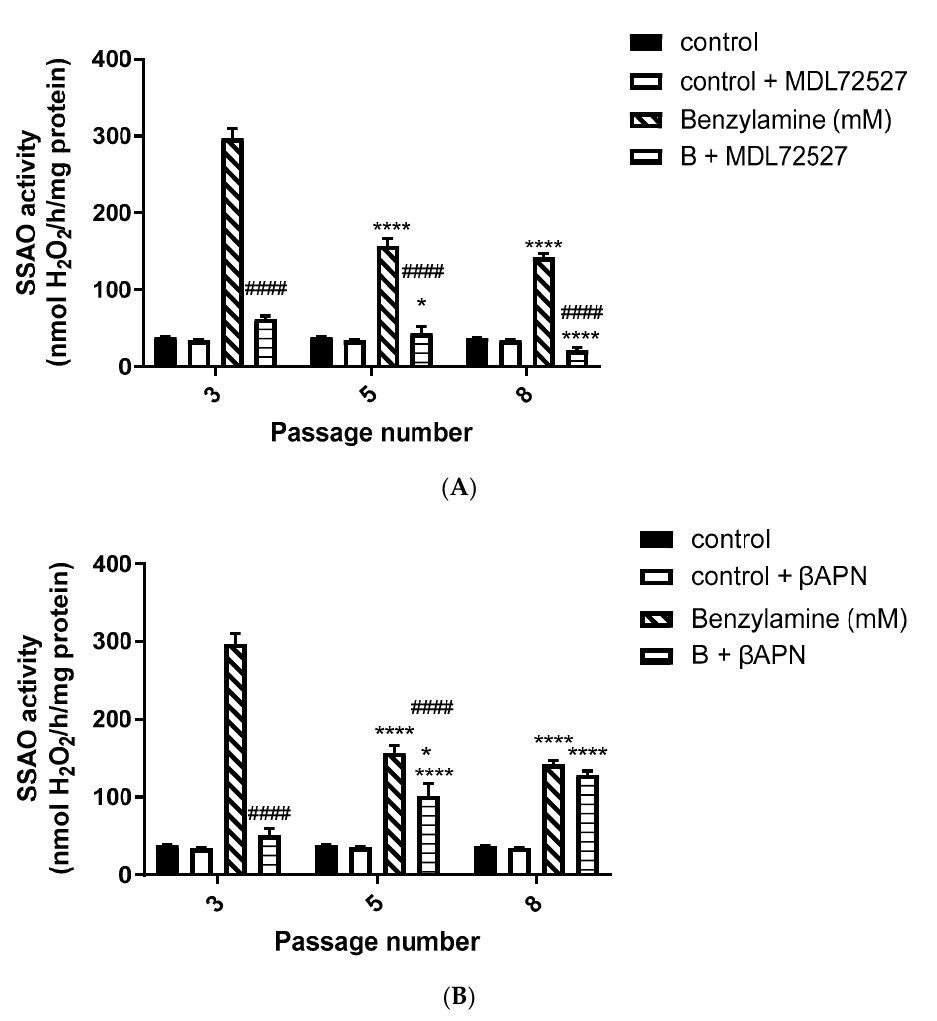
Figure 1. SSAO activity in VSMCs from passages 3, 5, and 8 at the basal level, and after MDL72527 and β APN treatment. ( A ) Cells were treated with a reaction mixture containing 0.5 mM benzyla- mine (hatched bars); 0.5 mM benzylamine + 100 μ M MDL72527 (horizontal line bars); a reaction mixture without benzylamine (control—solid bars) and a reaction mixture without benzylamine + MDL72527 (control + MDL72527, open bars).**** p < 0.0001 for cells passage 5 vs . 3 and 8 vs . 3 after treatment with benzylamine; **** p < 0.0001 for cells passage 8 vs. 3 and * p < 0.05 for cells passage 5 vs. 8 after treatment with benzylamine + MDL72527; #### p < 0.0001 for B + MDL vs . benzylamine at passages 3, 5, and 8. ( B ) Cells were treated with a reaction mixture containing 0.5 mM benzylamine (hatched bars); 0.5 mM benzylamine + 200 μ M β APN (horizontal line bars); a reaction mixture with- out benzylamine (control—solid bars) and a reaction mixture without benzylamine + β APN (control + β APN, open bars).**** p < 0.0001 for cells passage 5 vs . 3 and 8 vs. 3 after treatment with benzyla- mine; **** p < 0.0001 for cells passage 5 vs . 3 and 8 v s. 3, and * p < 0.05 for cells passage 5 vs . 8 after